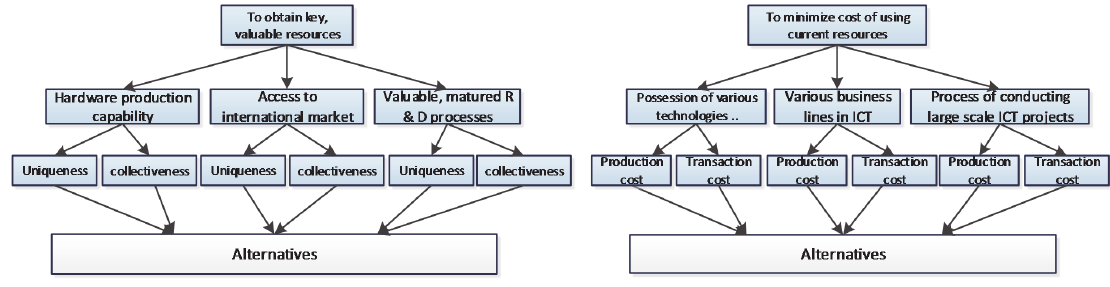
Fig. 6. AHP hierarchies of the proposed framework